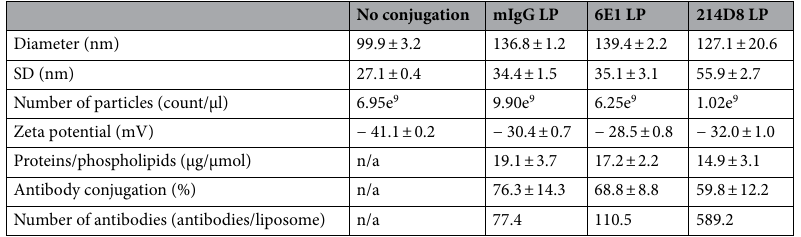
Table 1. Characterization of